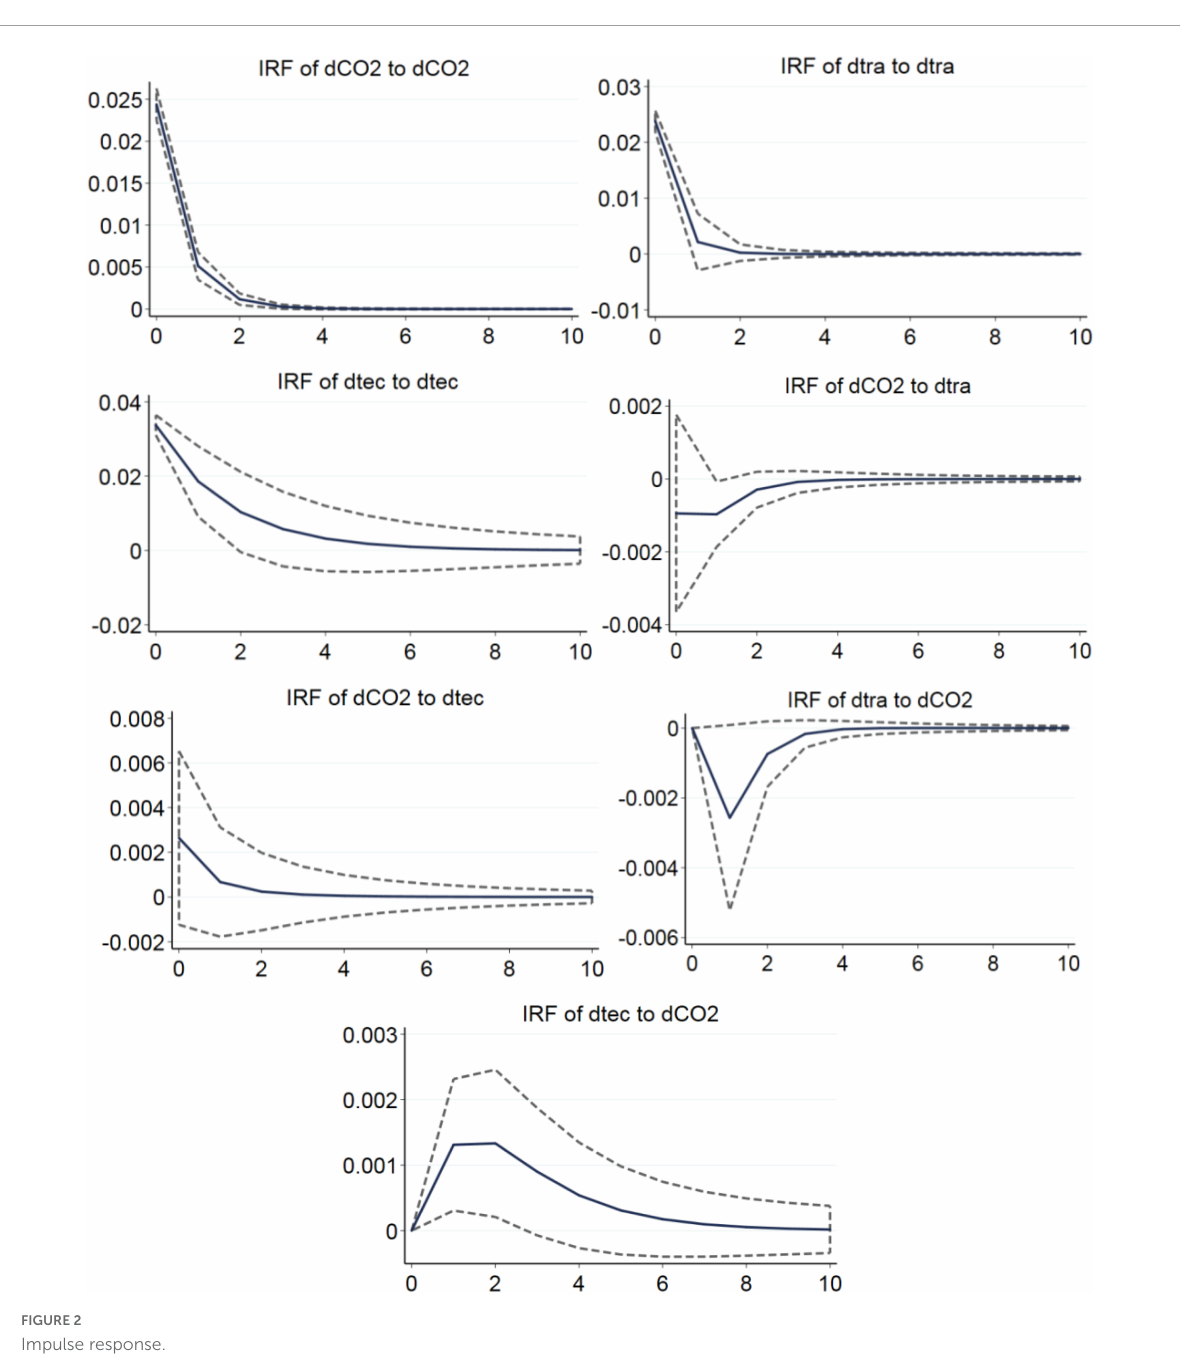
trade reacts quickly in an prominent, smooth negative